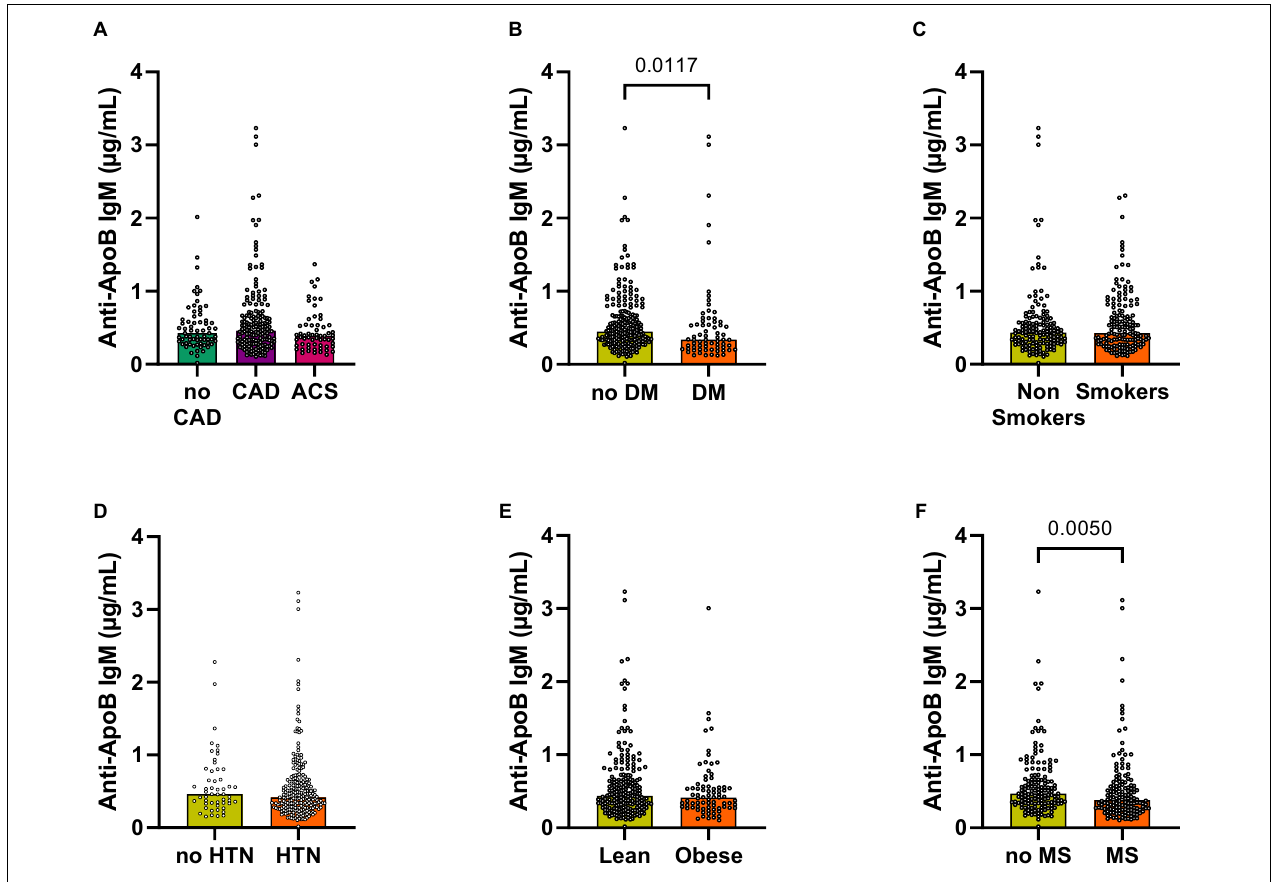
FIGURE 5 | Associations of anti-ApoB IgM plasma levels with cardiovascular risk factors. Anti-ApoB IgM plasma levels were quantified by ELISA and grouped according to (A) patient diagnosis or (B–F) cardiometabolic risk factors. CAD, coronary artery disease; ACS, acute coronary syndrome; DM, diabetes mellitus; HTN, hypertension; MS, metabolic